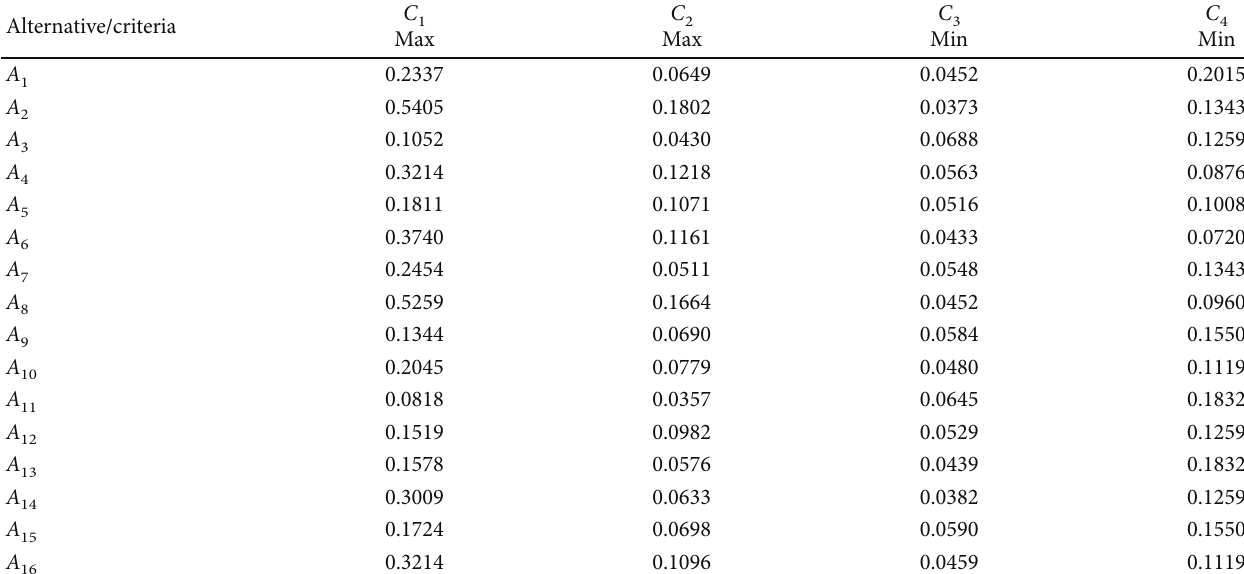
Table 3: Weighted normalized decision-making matrix.